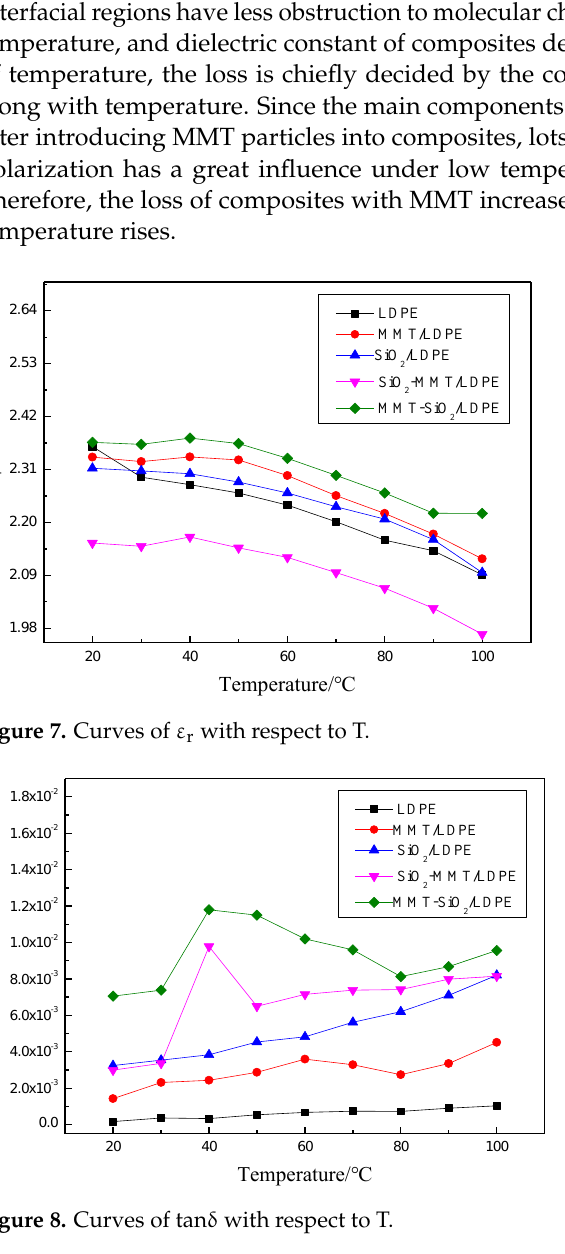
Figure 8. Curves of tanδ with respect to T.